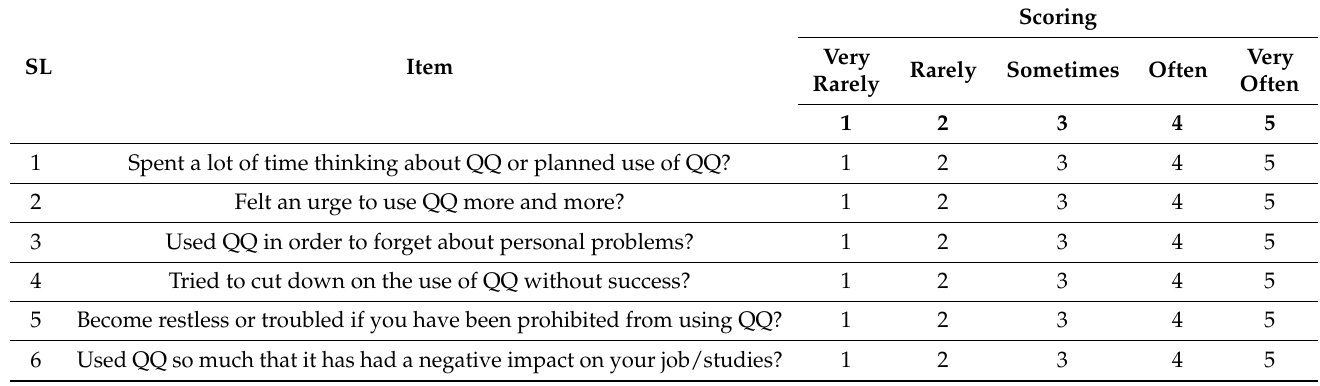
Table A1. English version: The Problematic QQ Use Scale for